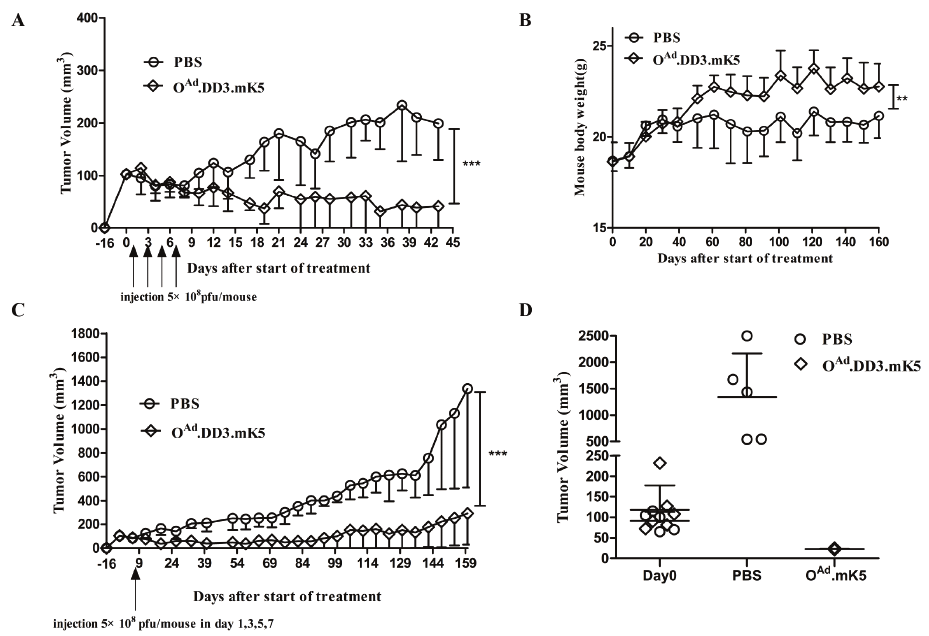
Figure 5: O Ad .DD3.mK5 displays antitumor activity in vivo . A, C. Tumor growth curve of LNCaP xenograft tumors after intratumoral injection of 5×10 8 pfu/mouse adenoviruses . O Ad .DD3.mK5 or PBS were injected 16 days after subcutaneous inoculation of LNCaP cells. B. Body weight of mouse after initial injection. D. Volume of tumors that grew in LNCaP mice to initial volume. After that, mice were treated with PBS or O Ad . DD3.mK5 for 160 days. Data are shown as the mean ± S.D. *P < 0.05, **P < 0.01, ***P <